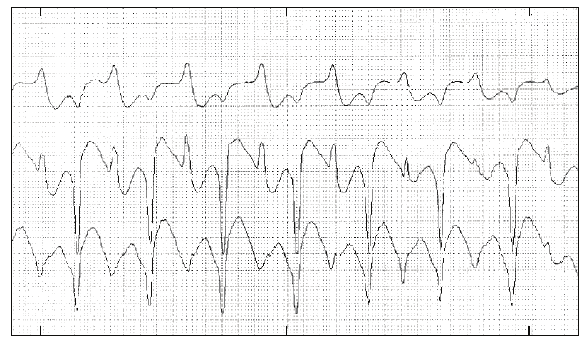
Figure 2: Holter monitoring revealing a bidirectional ventricular